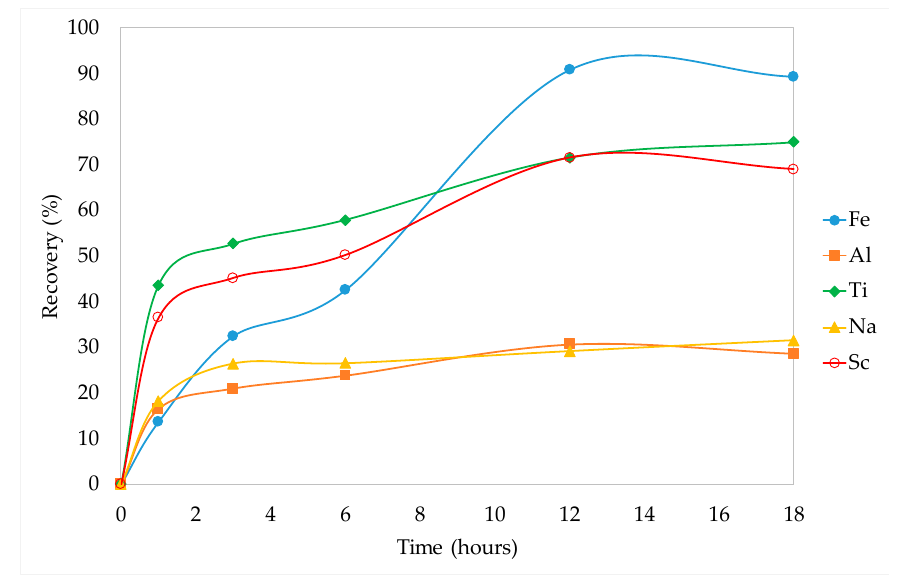
Figure 5. Kinetic curves for metals dissolution by leaching BR with [Emim][HSO 4 ] at 1, 3, 6, 12, and 18 h, 200 rpm, 175 °C and 5% w / v pulp density.